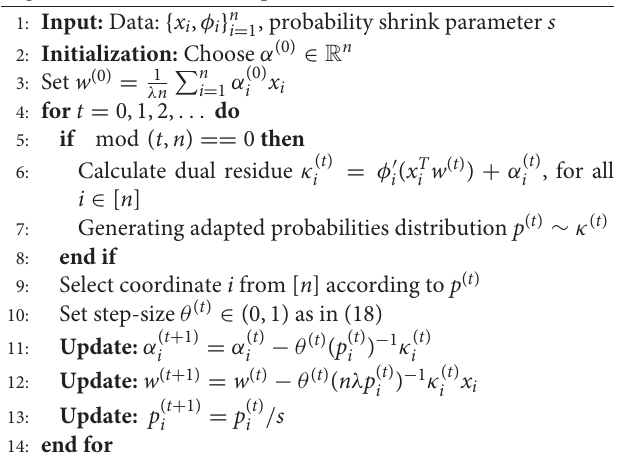
Algorithm 2 Heuristic Adaptive Dual Free SDCA